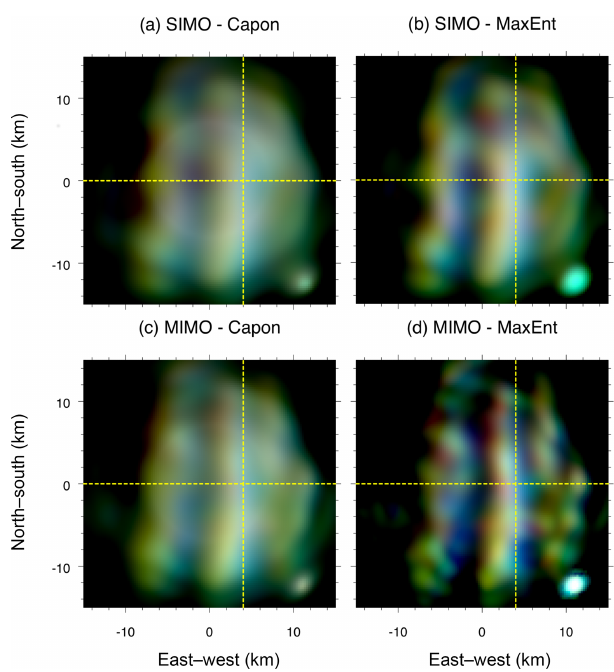
Figure 3. EW–NS images for z = 85 . 8km obtained from applying four different implementations, (a) SIMO-Capon, (b) SIMO-MaxEnt, (c) MIMO-Capon, and (d) MIMO-MaxEnt, at 00:56:55UT on 17 July 2017, i.e., Event 1. Images are color coded the same as in Fig. 2. The yellow dashed horizontal and vertical lines represent the location of the NS–EW cuts shown in later figures for Event 1.